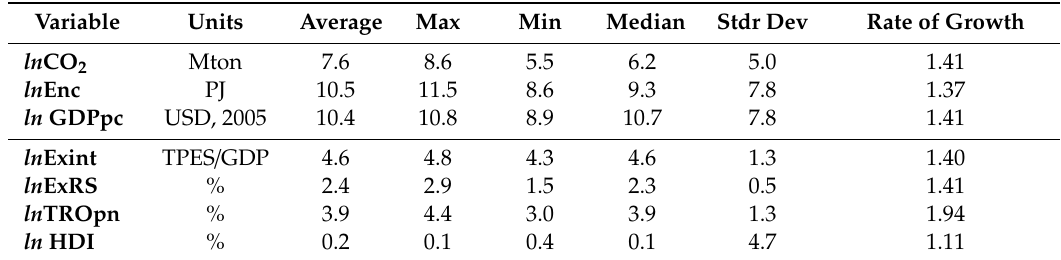
Table 1. Variable definitions and descriptive statistics (average values in NAFTA countries [35,43])